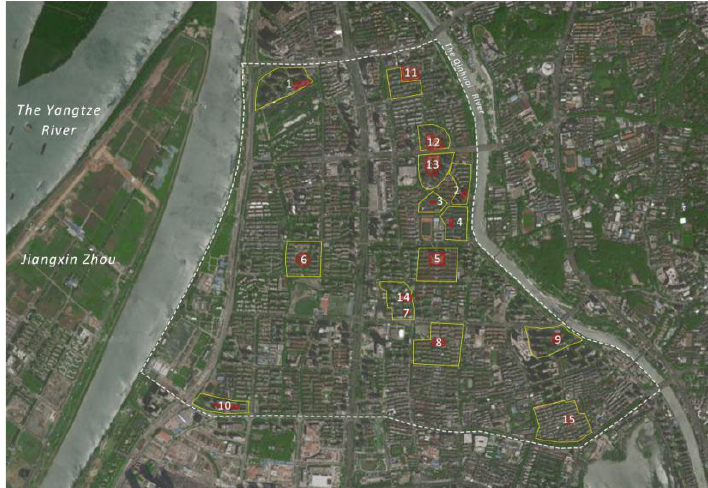
Figure 2. Locations of sample residential neighborhoods in Longjiang Region. Table 1. Pictures of the sample residential neighborhoods.